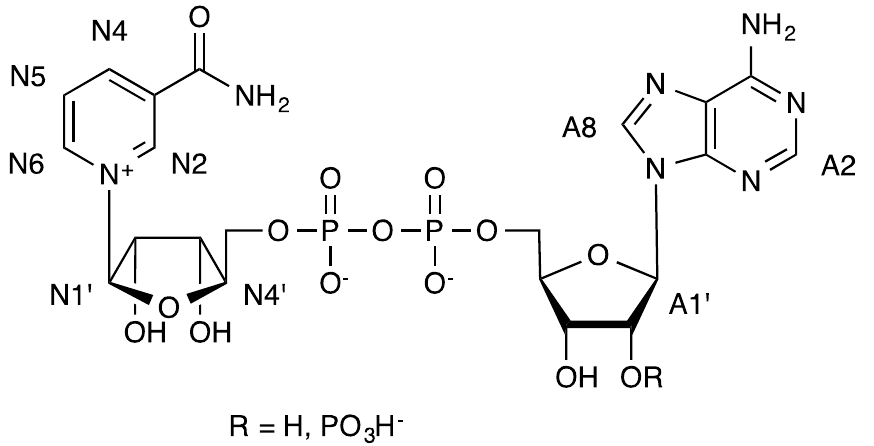
H − ) and numbering used in the 3